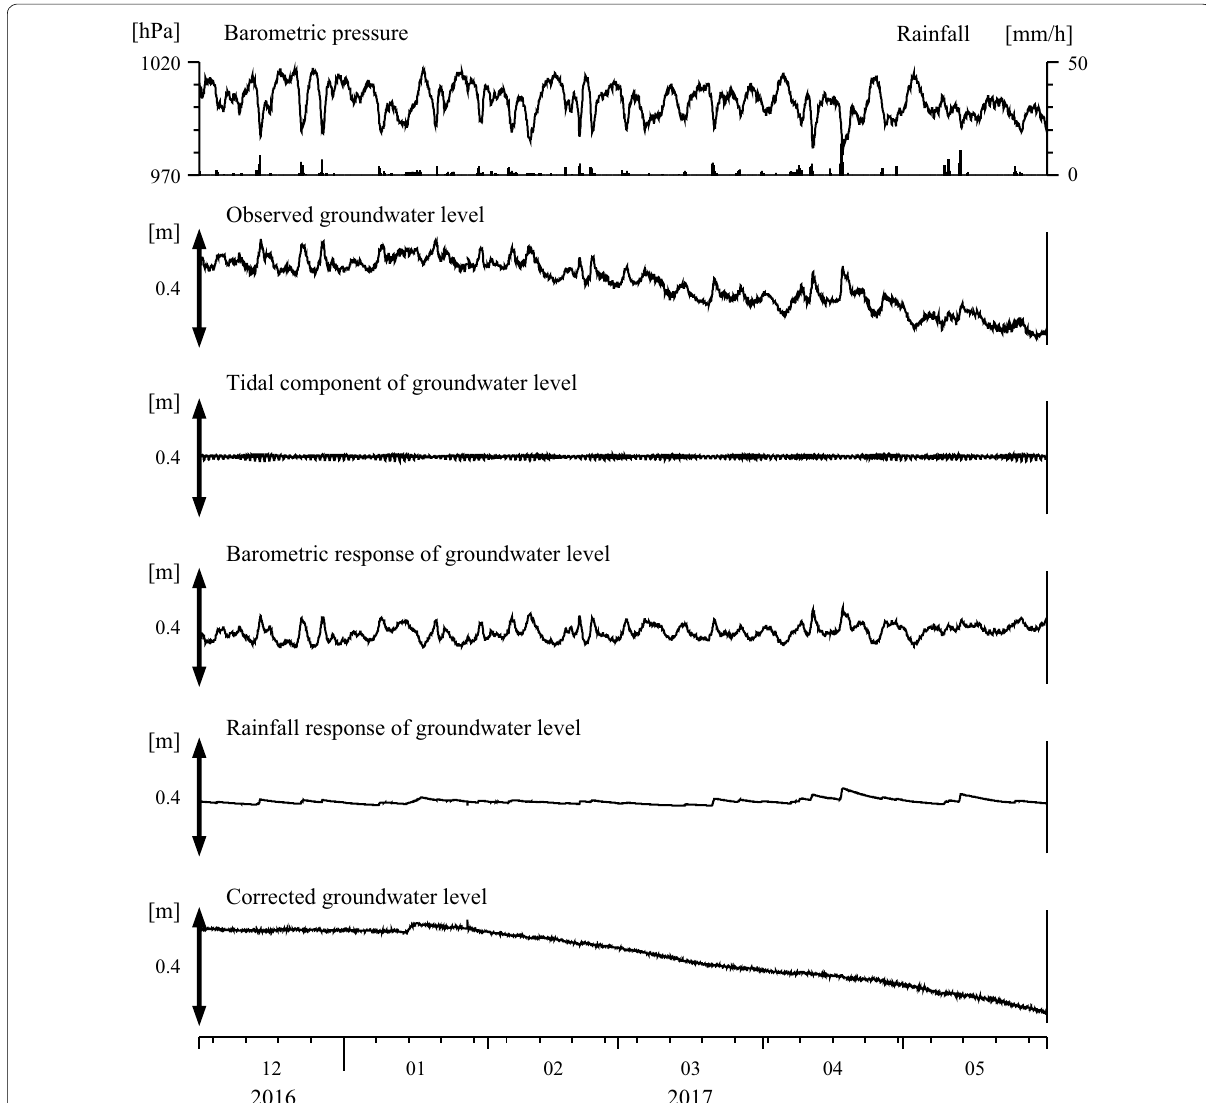
Fig. 4 Observational data and correction of groundwater levels at HKSi from December 2016 to May 2017. Barometric pressure, rainfall (bars in top plot), and groundwater levels were observed at HKS, and the tidal, barometric, and rainfall components of the groundwater level response were identified and removed using BAYTAP-G (Tamura et al. 1991) and the regression of Matsumoto (1992) to produce the final corrected groundwater level trend. Barometric pressure and rainfall are refer to left and right scales,